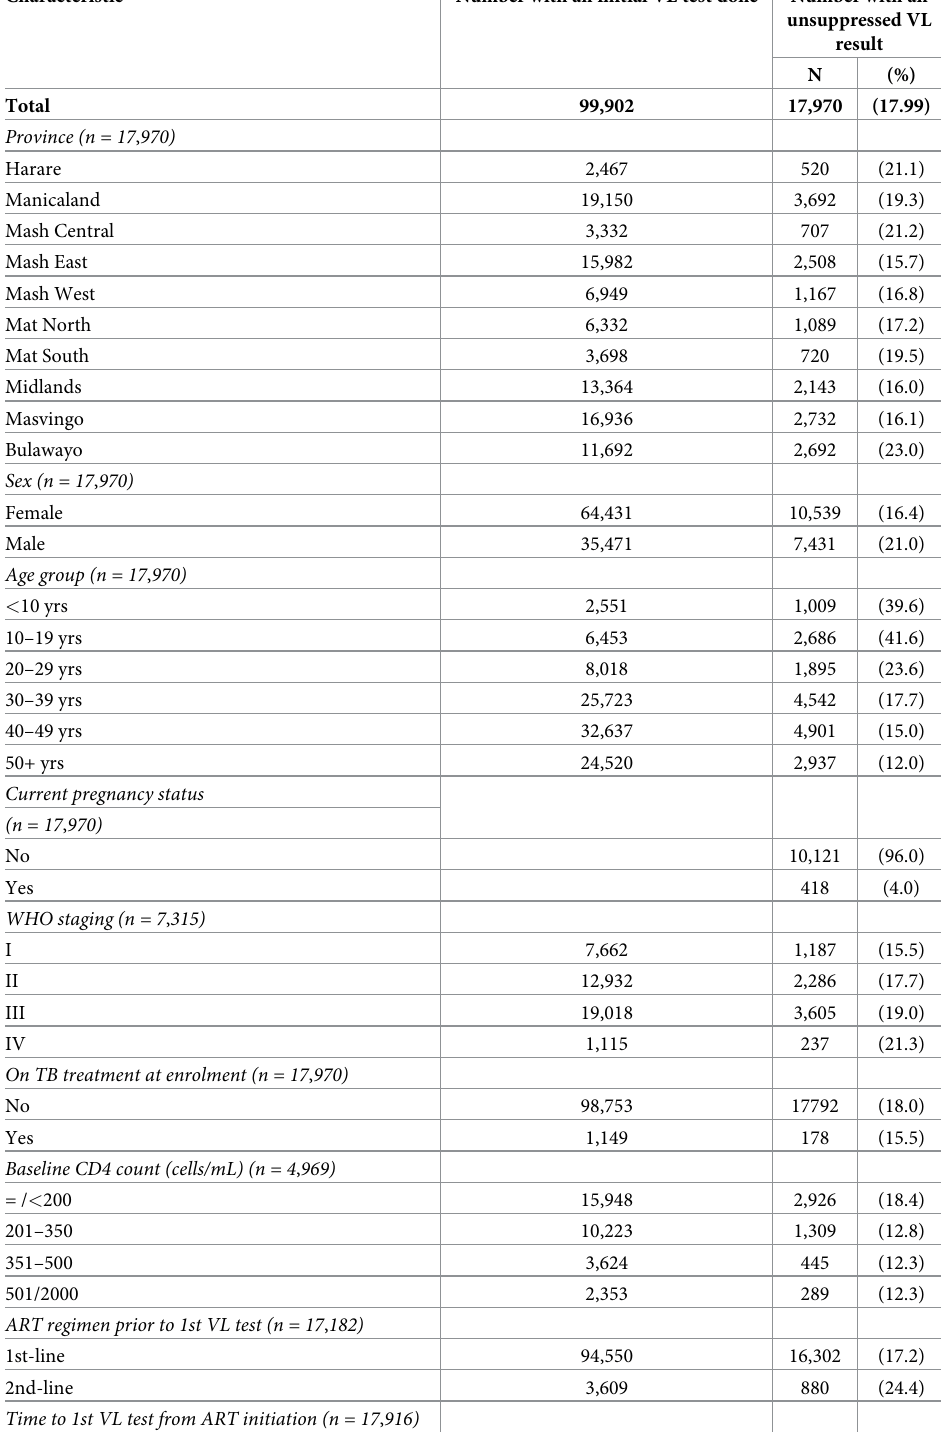
Table 2. Demographic and clinical characteristics of PLHIV on ART for � 12 months with an initial unsuppressed viral load ( > 1000 copies/mL) at sites using the electronic Patient Management System from 2004 to 2017 in